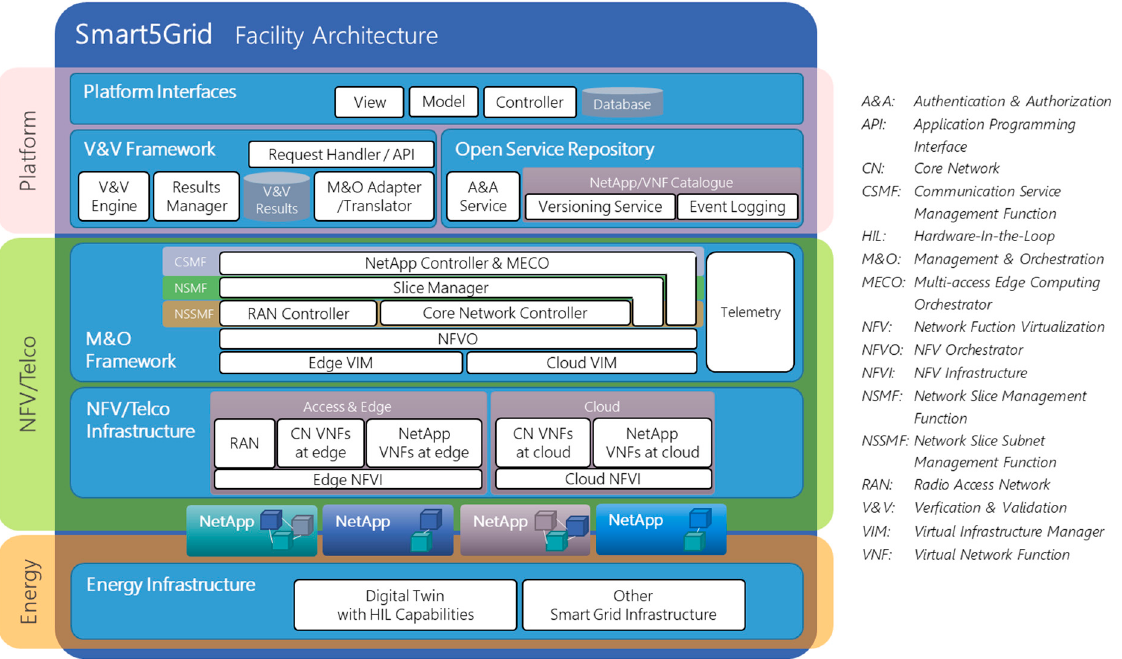
Figure 5. Smart5Grid functional architecture.